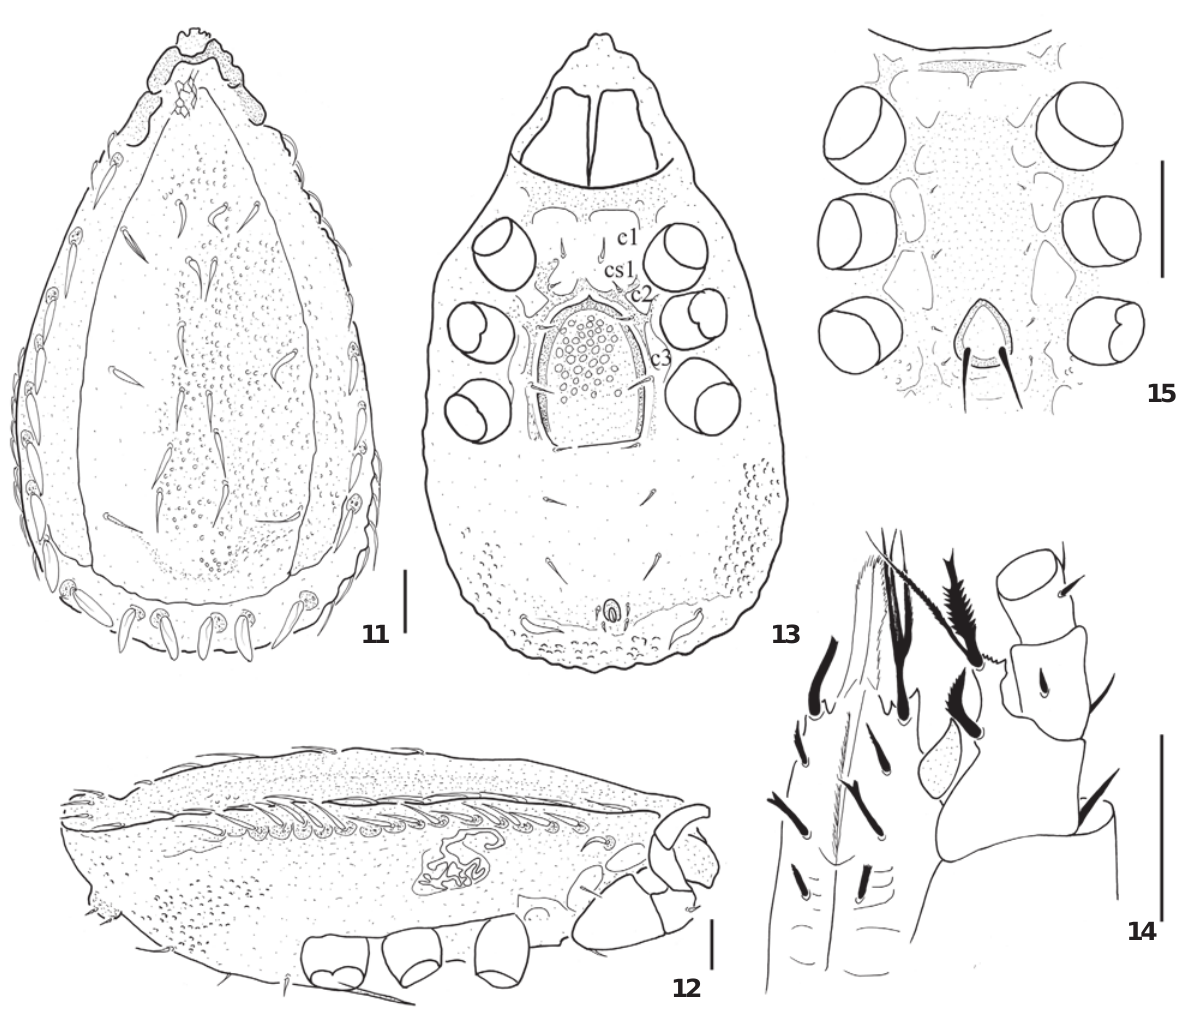
Figures 11-15. Kaszabjbaloghia ecuadorica sp. nov. : (11) dorsal view; (12) lateral view; (13) ventral view; (14) ventral view of gnathosoma, female; (15) sternal region, male. Scale bar: 100